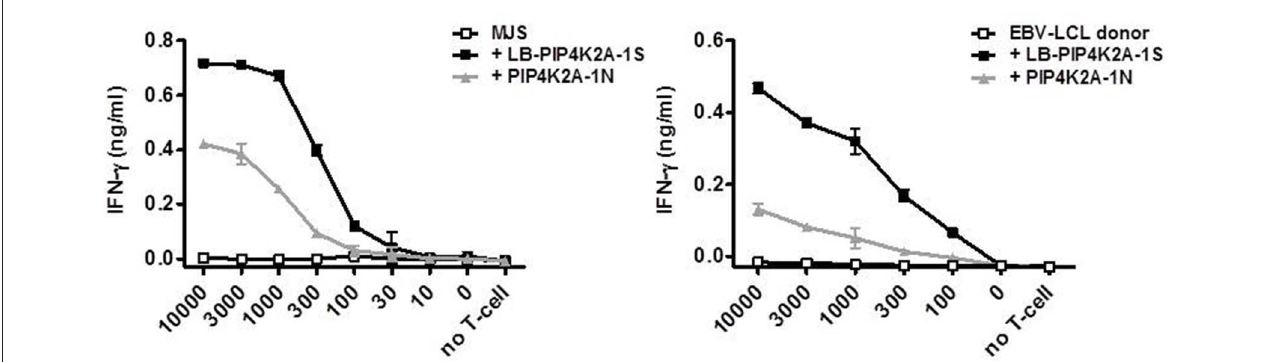
FIGURE 2 | Cell type-specific recognition of endogenously expressed PIP4K2A-1N donor variant. Full-length genes encoding LB-PIP4K2A-1S and PIP4K2A-1N were retrovirally transduced in MJS (left) or donor EBV-LCL (right) and transduced cells were isolated by flow cytometric sorting based on expression of marker gene GFP. T-cell recognition by clone 100 of the different cell lines was measured in IFN- γ ELISA. Indicated is the release of IFN- γ (ng/ml) by T-cell clone 100 upon co-incubation with indicated numbers of transduced MJS cells or EBV-LCL. Indicated are mean and standard deviation of duplicate wells. One representative of three independent experiments is